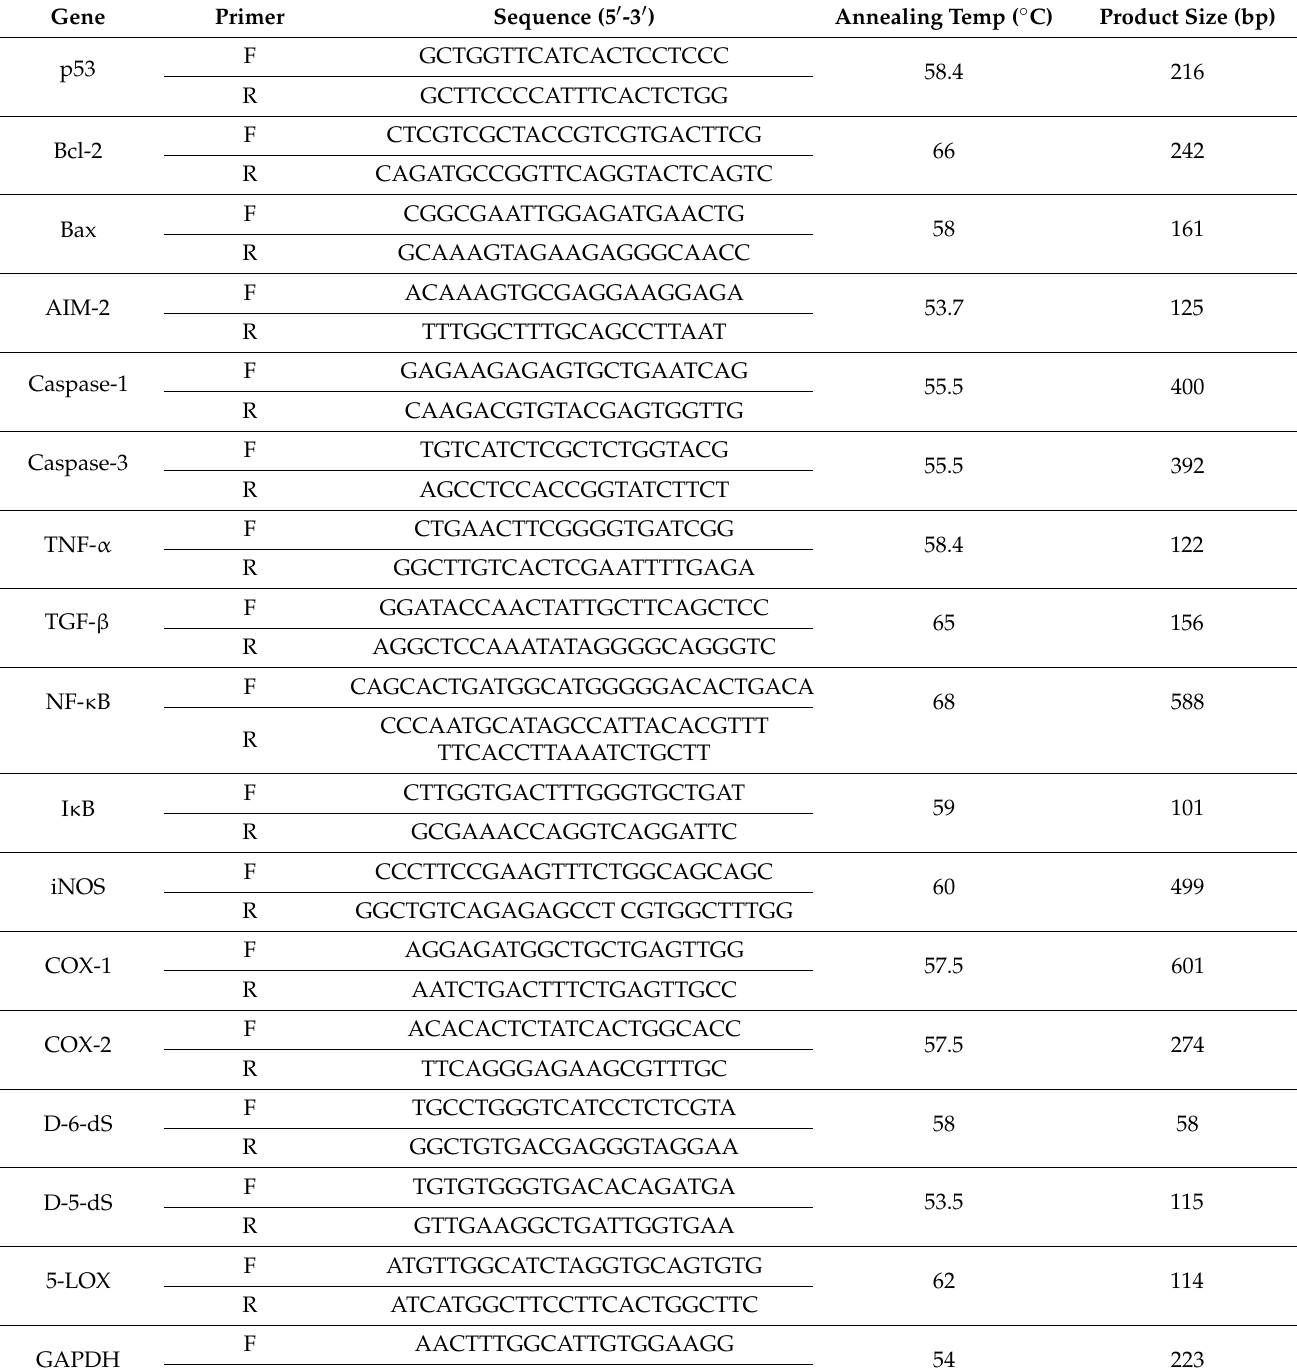
Table 1. Details of primer product size and their respective annealing temperatures used in semi- quantitative